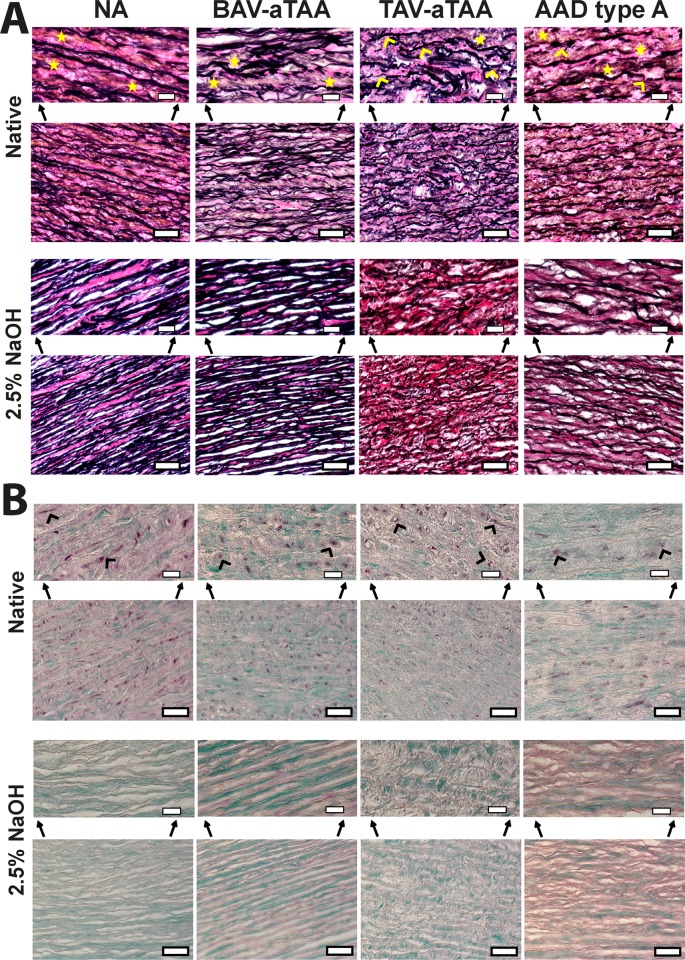
Elastika van Gieson and Masson Trichrome Goldner stained aortic NA and aneurysmal/dissection tissue.In (A) representative images of Elastika van Gieson stained NA and aneurysmal aortic tissue, either native (upper row) or decellularized (with 2.5% NaOH; lower row), are shown as well as magnified areas of the representative images. Yellow asterisks represent muscle cells and yellow arrowheads elastic fibers. In (B) representative images as well as magnified areas of Masson Trichrome Goldner stained aortic tissue are shown. The upper row shows native tissue of NA specimen, aneurysmal tissue of BAV- or TAV-origin as well as dissection specimen. Black arrowheads indicate cellular material. In the row below the corresponding decellularized tissues are depicted. Scale bar represents 50μm and in the magnified areas 20μm.